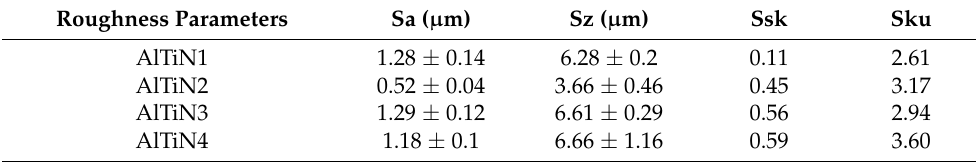
Table 6. Area surface roughness parameters after stripping of AlTiN coating.